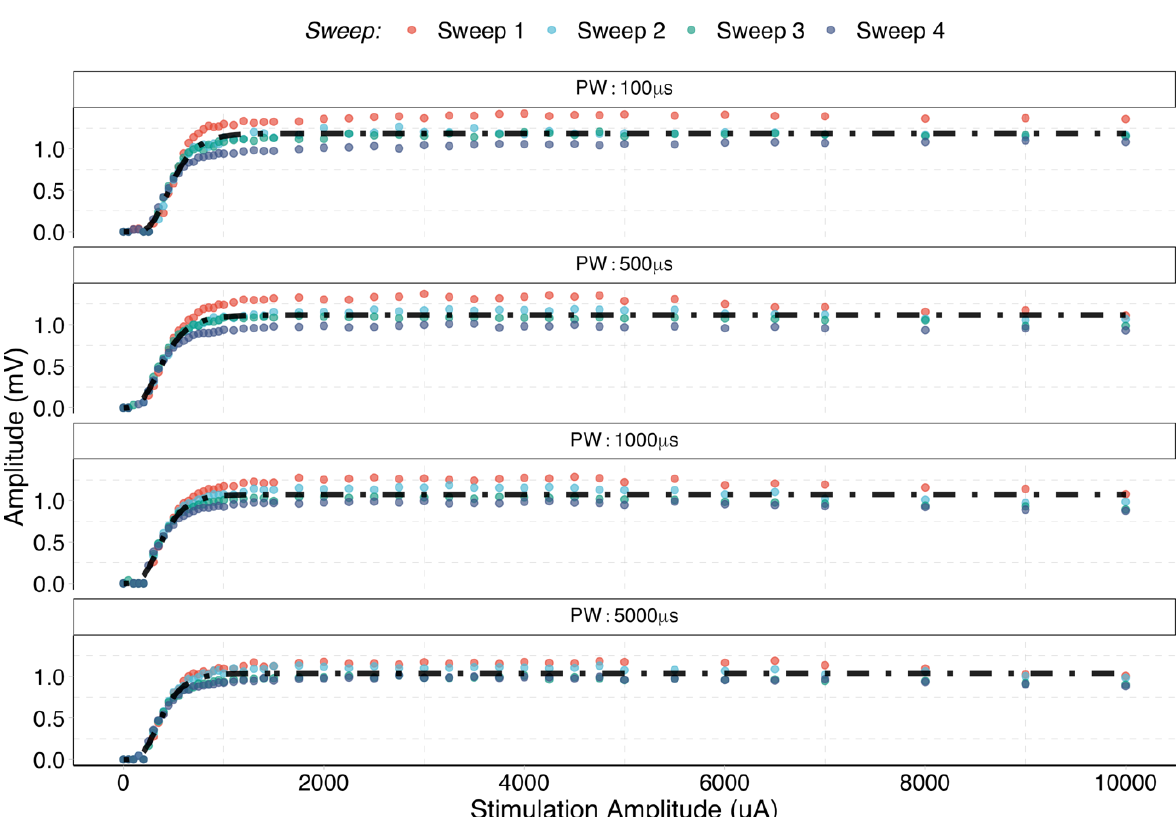
Figure 5. Observed (dots) and predicted values (dot–dashed line) for a single animal. Each colour represents a single eCAP from the four repetitions (i.e., sweeps) for each stimulation value and level of pulse-width.